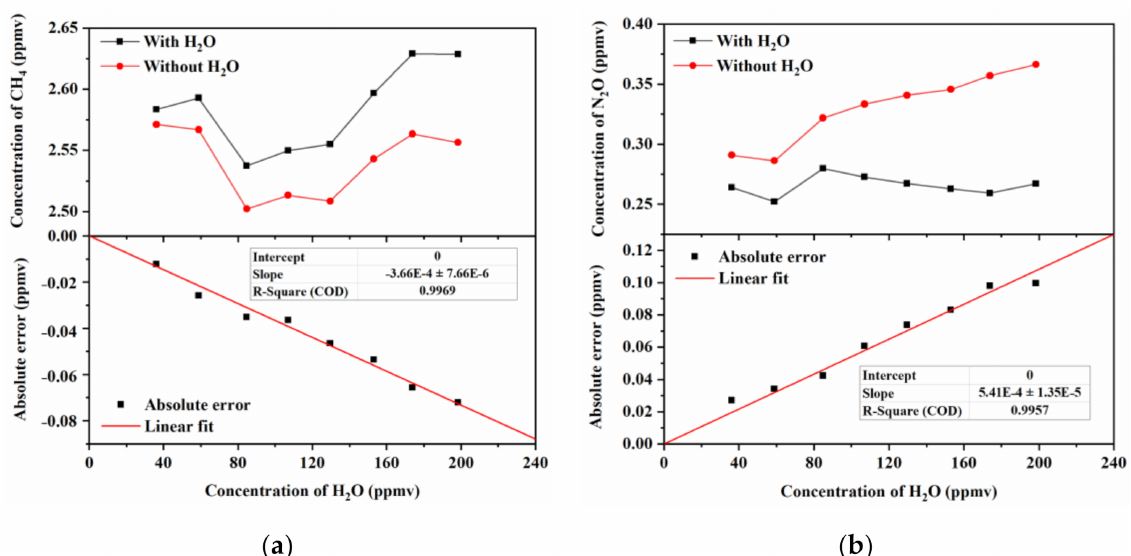
Figure 5. The differences of ( a ) CH 4 and ( b ) N 2 O concentrations between that determined with and without simultaneously determining the H 2 O concentration.